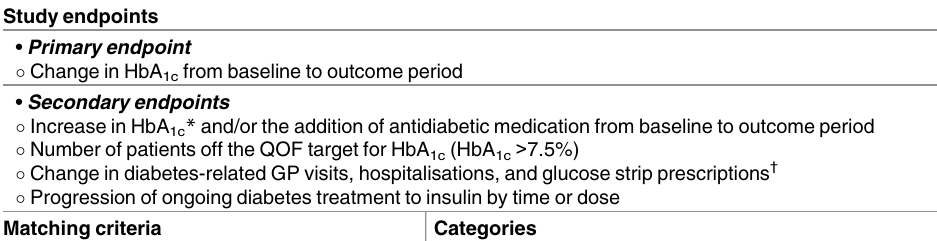
Table 1. Study endpoints and matching